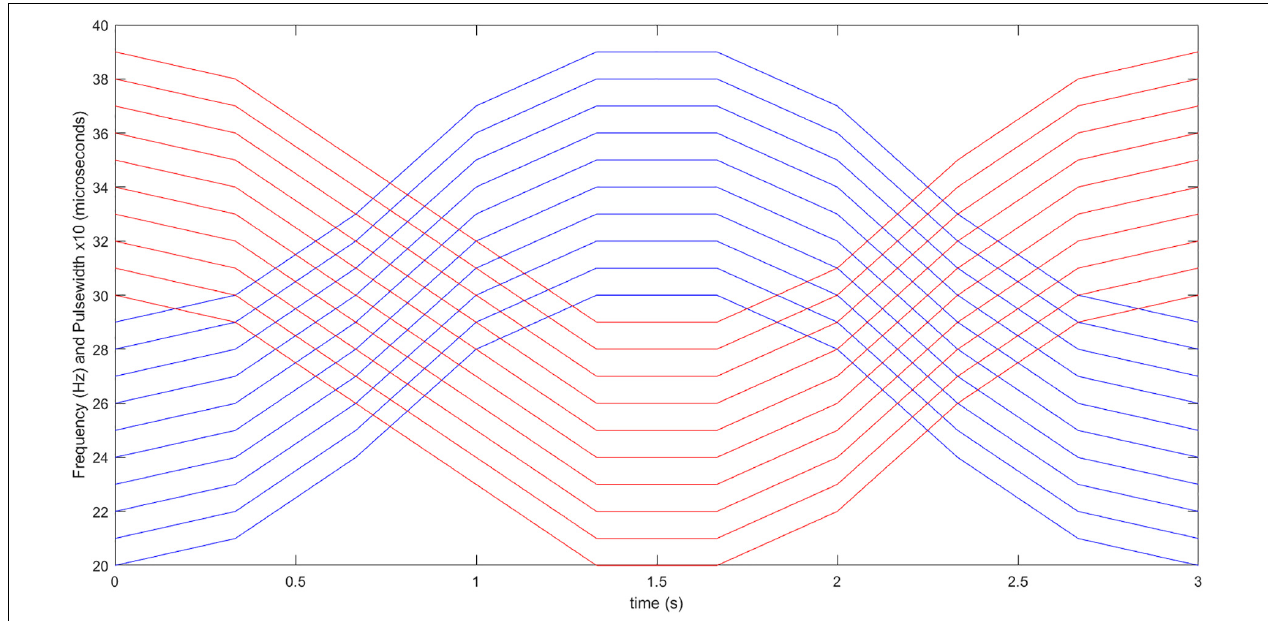
FIGURE 2 | Stimulation pattern with co-modulation of frequency and pulse width. Red and blue lines correspond to frequency and pulse width values throughout the 3-s long stimulation burst, for 10 consecutive repetitions of the functional movements. Initial (0 s) frequency and pulse width values are varied with sinusoidal patterns throughout the time, with updating interval of 0.33